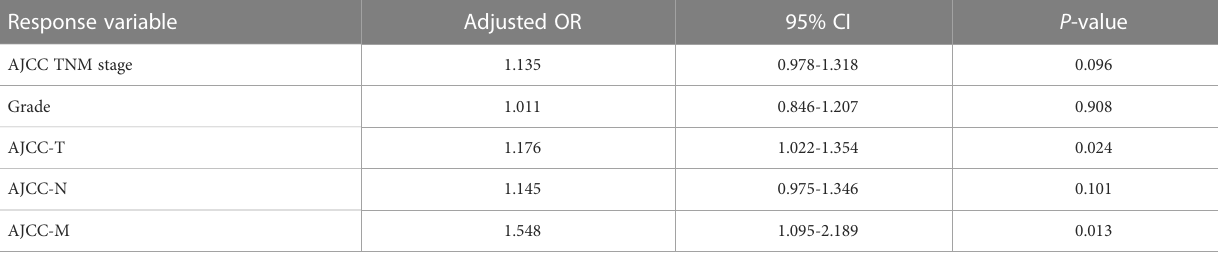
TABLE 2 The association between MOR mRNA expression and clinicopathological features overall.